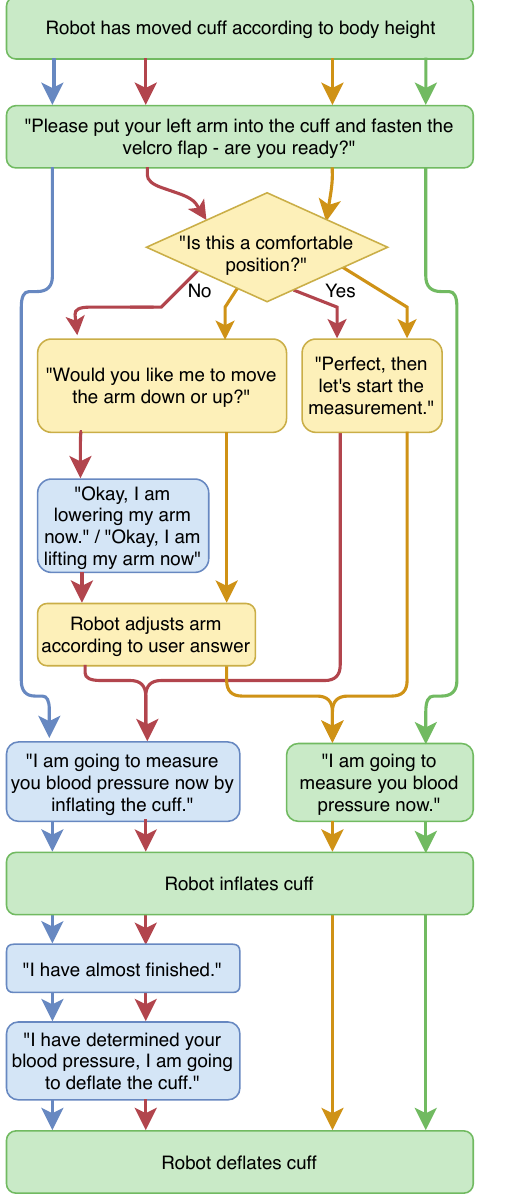
Figure 7: Flow chart of the middle third of the experiment. Behaviour and conditions marked as in Fig. 6.